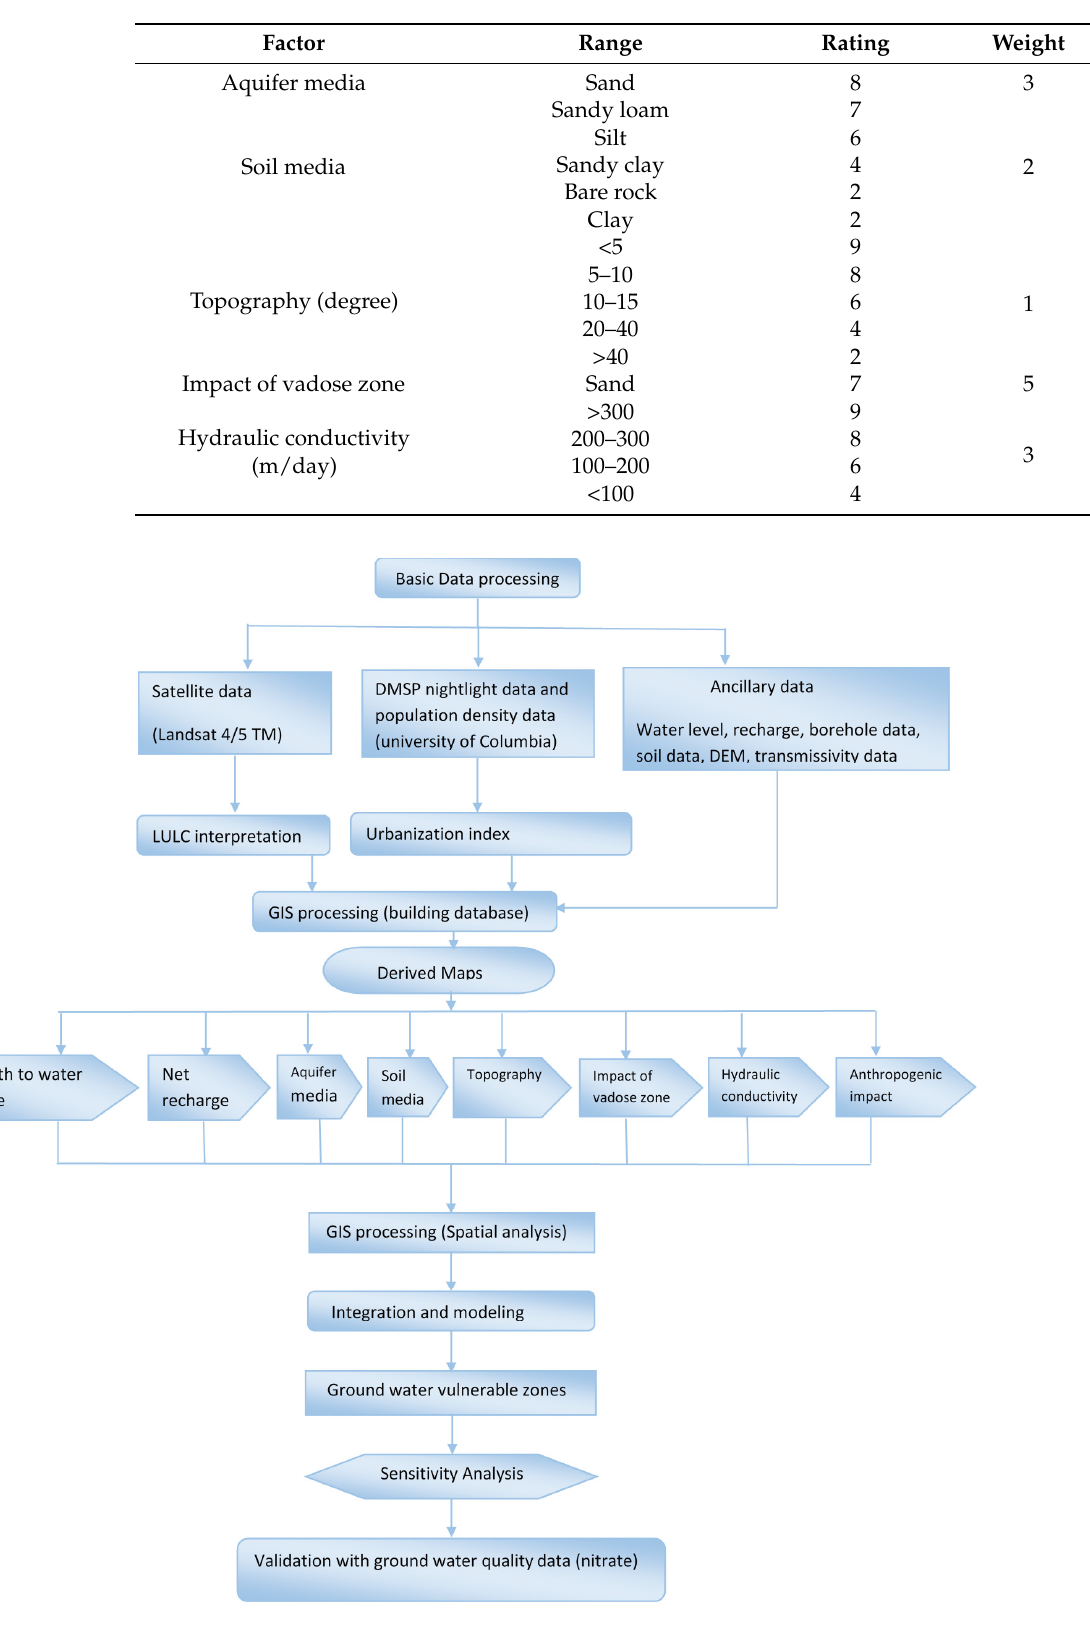
Figure 2. Data processing and adopted methodology